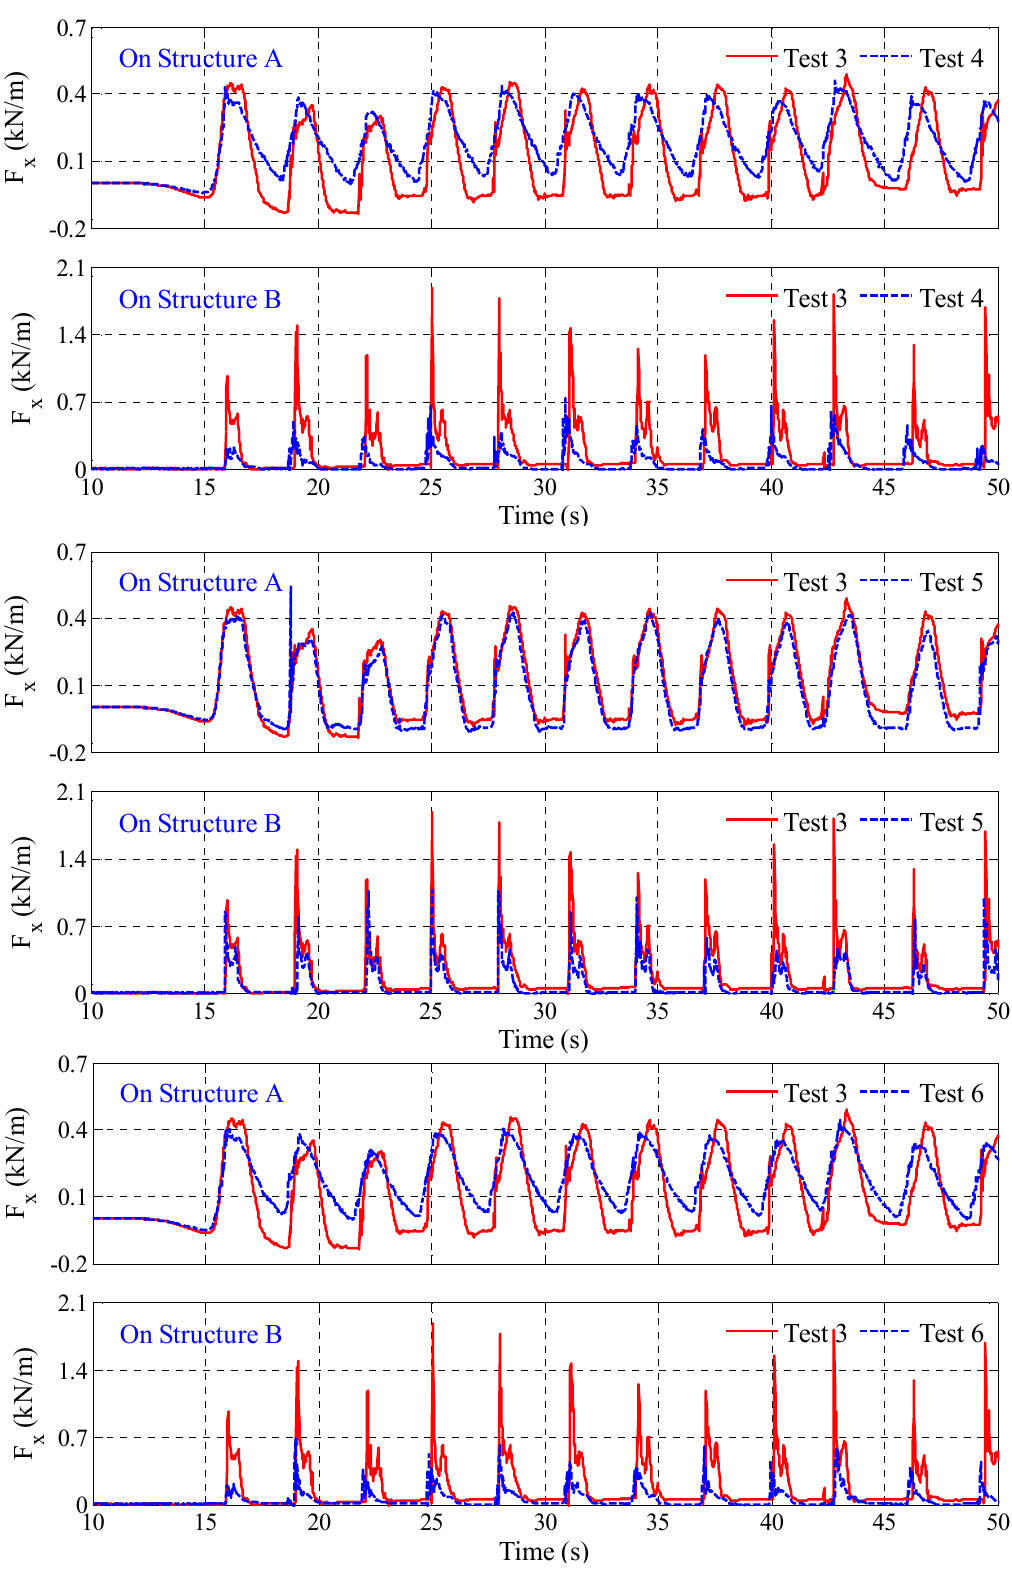
Figure 21. Comparison of the wave impact force on structure A and B measured in Test 3 (no armor block), Test 4 (accropodes), Test 5 (rubble) and Test 6 (accropodes and rubble).